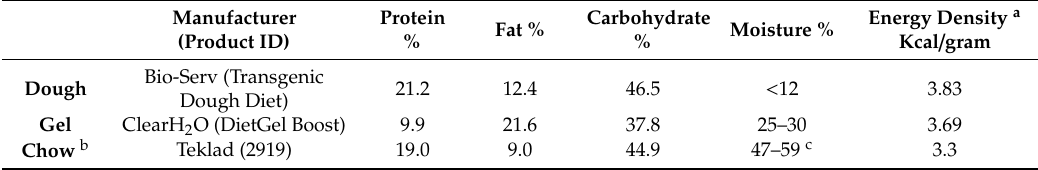
Table 1. Comparison of guaranteed analysis “as fed” reported by the